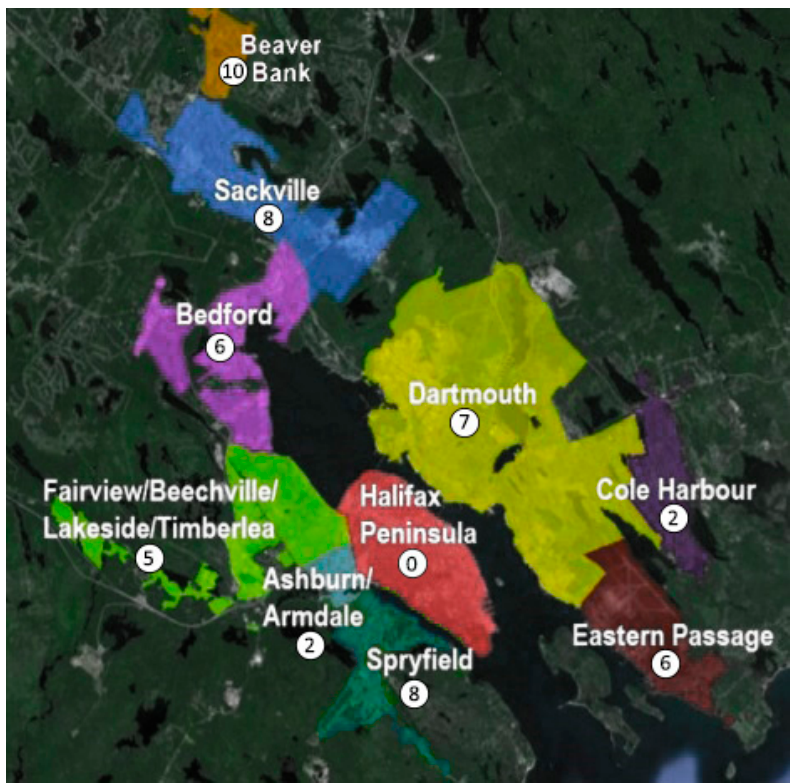
Figure 3. Overview of the 10 neighborhoods identified by, and adapted from, the Halifax Urban Master Plan [66]. Labels added to indicate number of plots from each neighborhood used in comparative study.